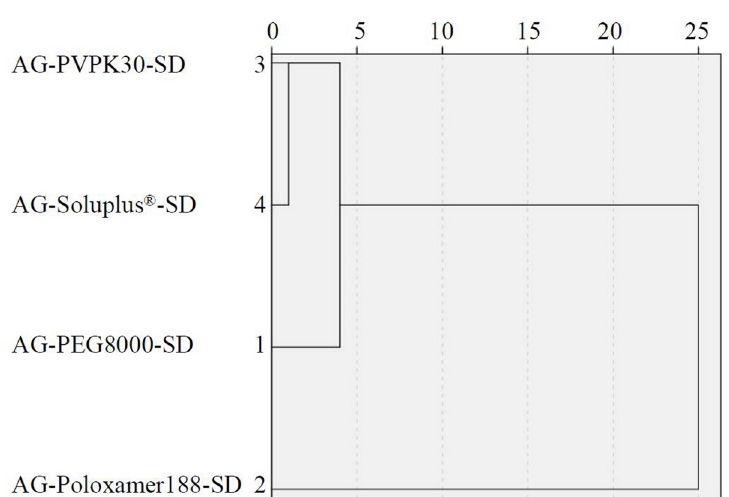
FIGURE 6 - Cluster analysis tree diagram by intergroup connection on the variable of particle size, specific surface area and pore volume.